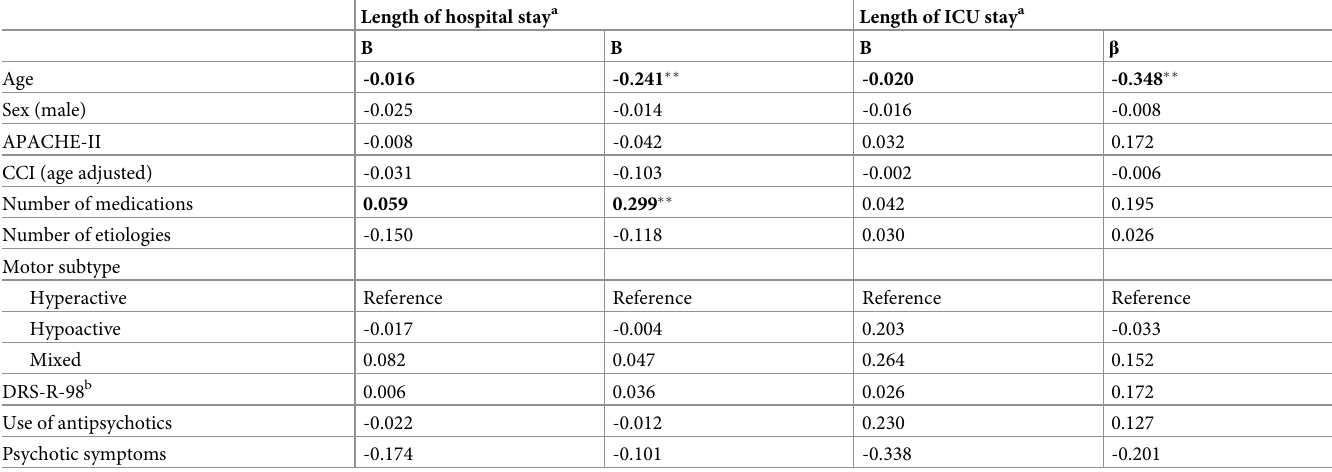
Table 4. Predicting factors for length of stay in hospital and